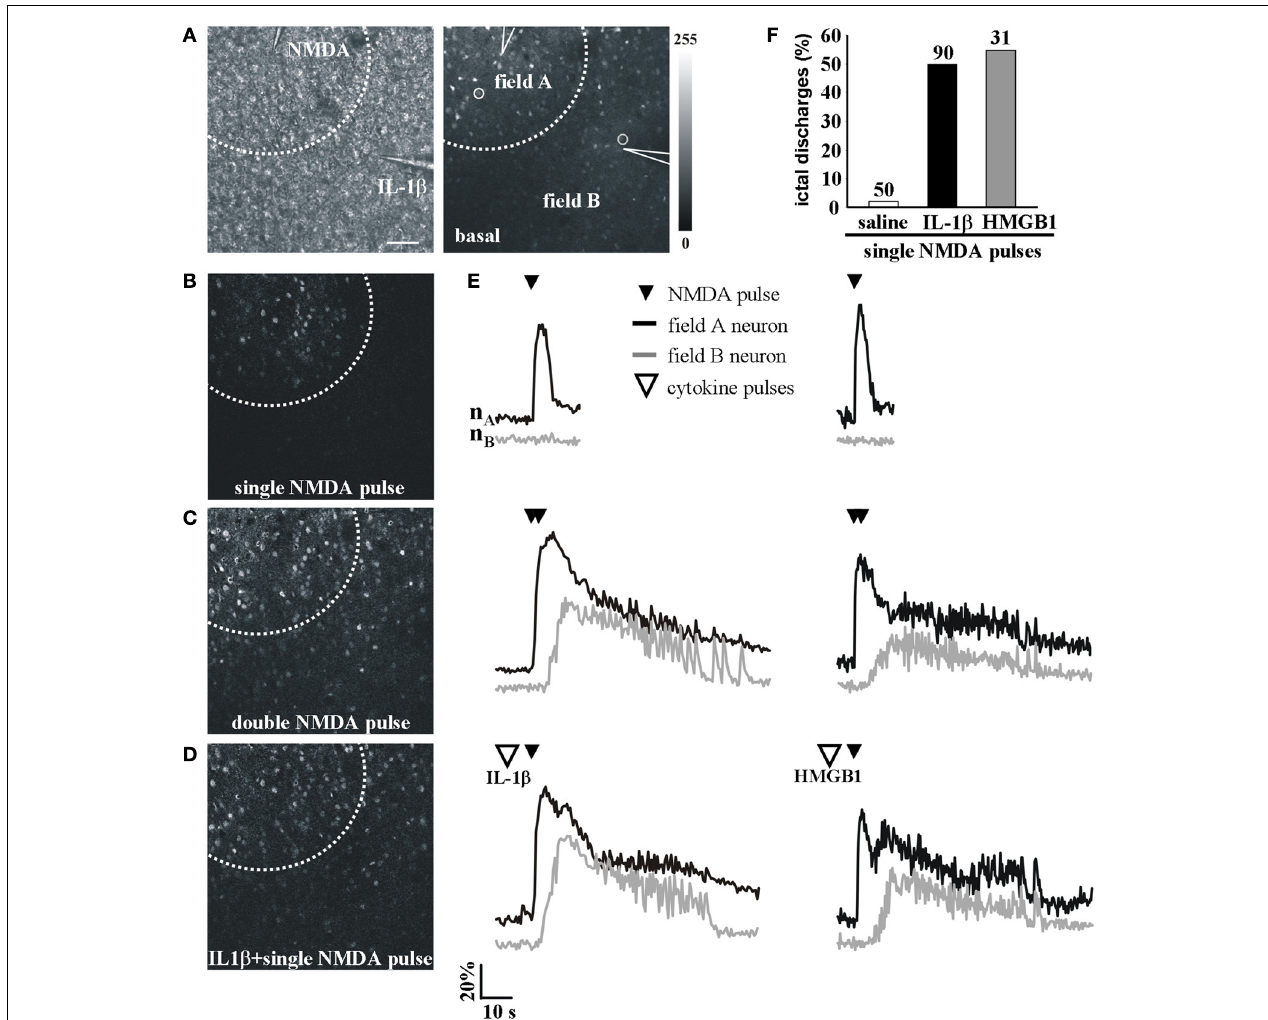
FIGURE 2 | IL-1 β and HMGB1 local applications enhance generation of focal ictal-like events. (A) DIC (left) and fluorescence (right) images of a cortical region from an EC slice showing the NMDA and the IL-1 β pipettes. Scale bar 100 μ . (B–D) Difference images of the neuronal Ca 2 + increase upon a single ineffective NMDA pulse (B) , a double (C) NMDA pulse that successfully evoked a focal ictal-like event, and (D) a single NMDA pulse that after IL-1 β also evoked a